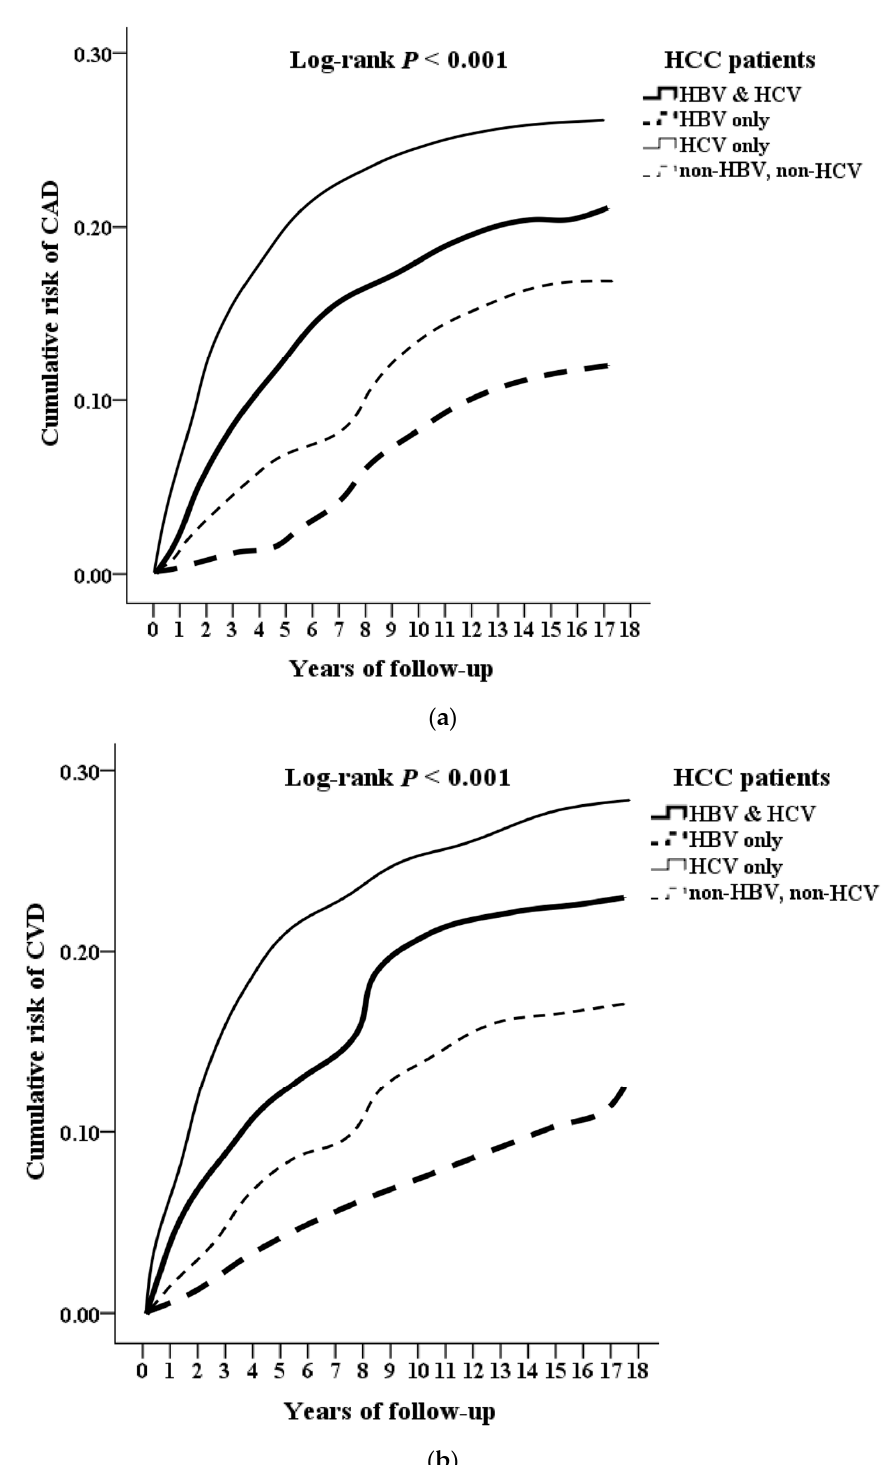
Figure 2. ( a ). Kaplan–Meier for cumulative risk of CAD among HCC patients, aged 20, and over strati fi ed by HBV and HCV with log-rank test. The abbreviations: hepatocellular carcinoma (HCC); hepatitis B (HBV); hepatitis C (HCV); coronary artery disease (CAD). ( b ). Kaplan–Meier for cumu- lative risk of CVD among HCC patients, aged 20. and over strati fi ed by HBV and HCV with log- rank test. The abbreviations: hepatocellular carcinoma (HCC); hepatitis B (HBV); hepatitis C (HCV); cerebrovascular disease (CVD).